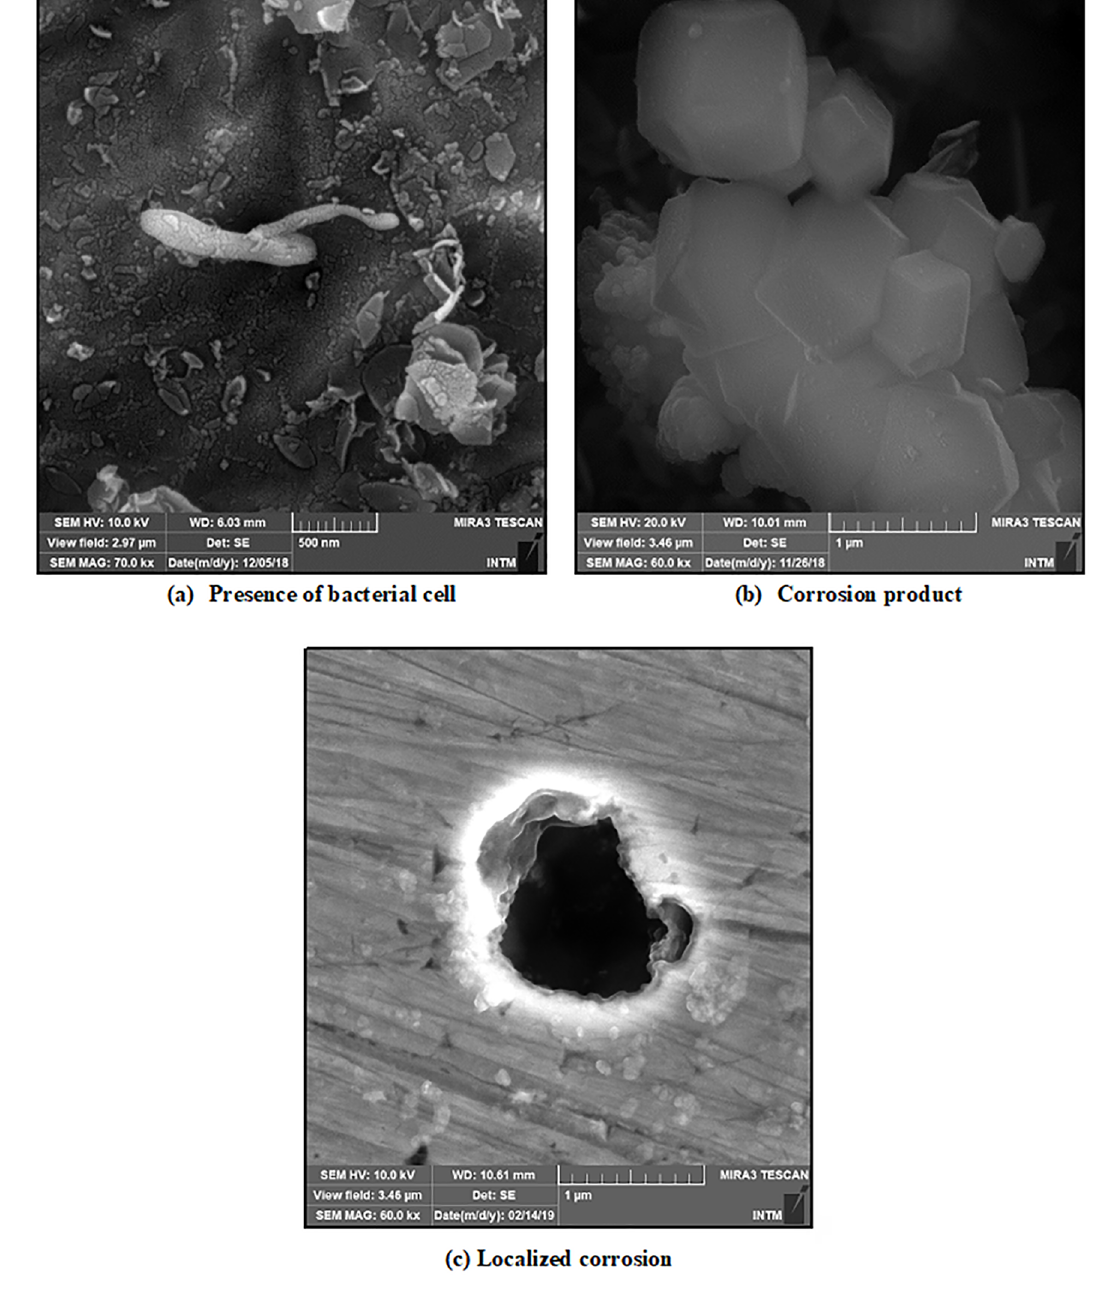
Figure 5. Micrographs of ASTM A131 grade A36 carbon steel. 48h, 1 week, 2 weeks, 3 weeks and 4 weeks, compared to the standard analysis